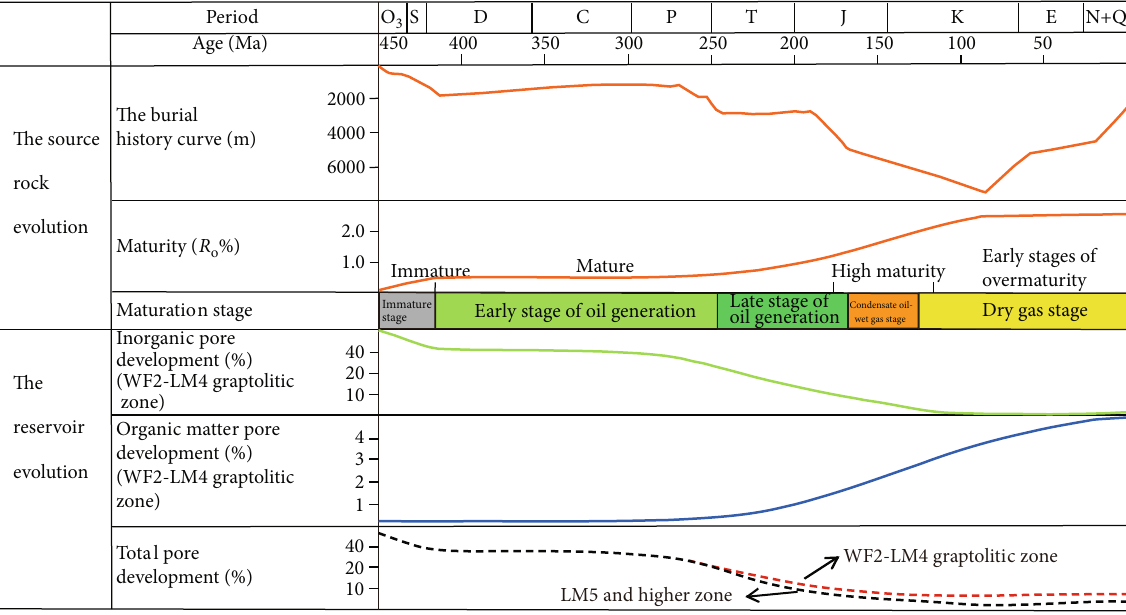
Figure 11: Porosity evolution history of the Wufeng and Longmaxi Formation shale gas reservoir in the Jiaoshiba area (modi fi ed from